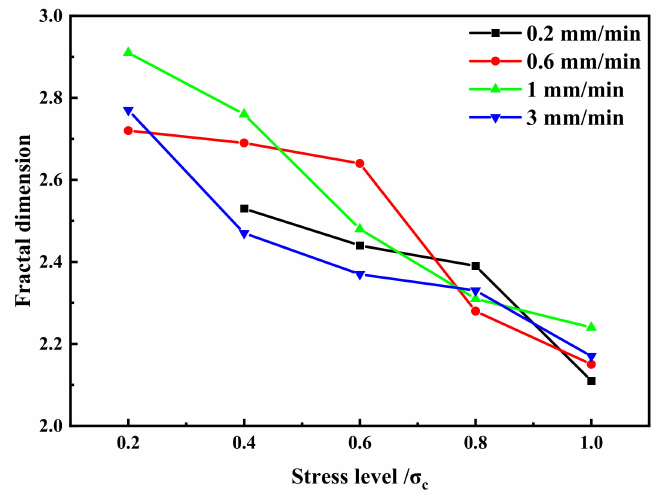
Figure 13. Evolution curves of spatial fractal dimension of coal samples under different loading